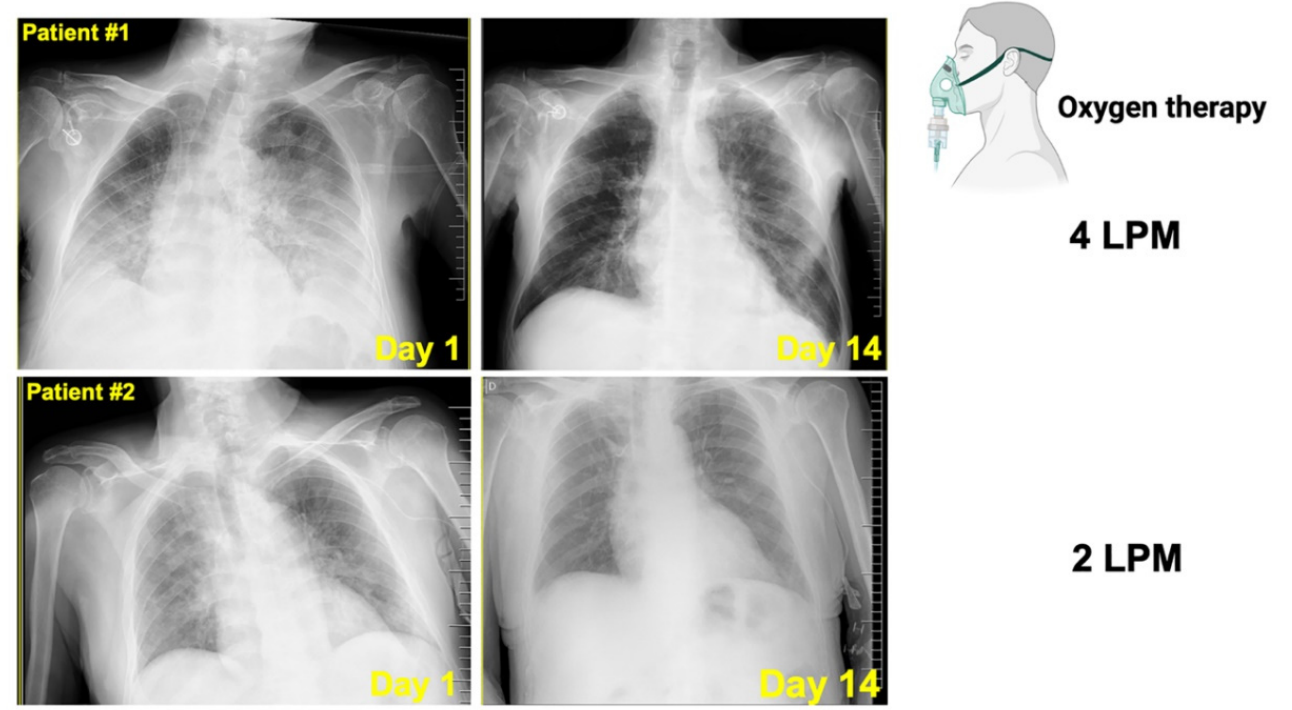
Figure 6. Radiological aspects of COVID-19 pneumonia in two cancer patients treated with silibinin. Top. Chest X-ray series in a 75-year-old male with stage IV pancreatic cancer and COVID-19 pneumonia. Left. Chest X-ray depicting bilateral lung infiltrates on illness day 3. Right. Chest X-ray depicting complete radiographic resolution of the pulmonary lesions after 10 days treatment with 1050 mg/day Legalon ® . Bottom. Chest X-ray series in a 70-year-old male with stage IV gastric cancer and COVID-19 pneumonia. Left. Chest X-ray depicting bilateral lung infiltrates on illness day 1. Right. Chest X-ray depicting complete radiographic resolution of the pulmonary lesions after 10 days treatment with 1050 mg/day Legalon ® (LPM: Liters per minute, L/min).